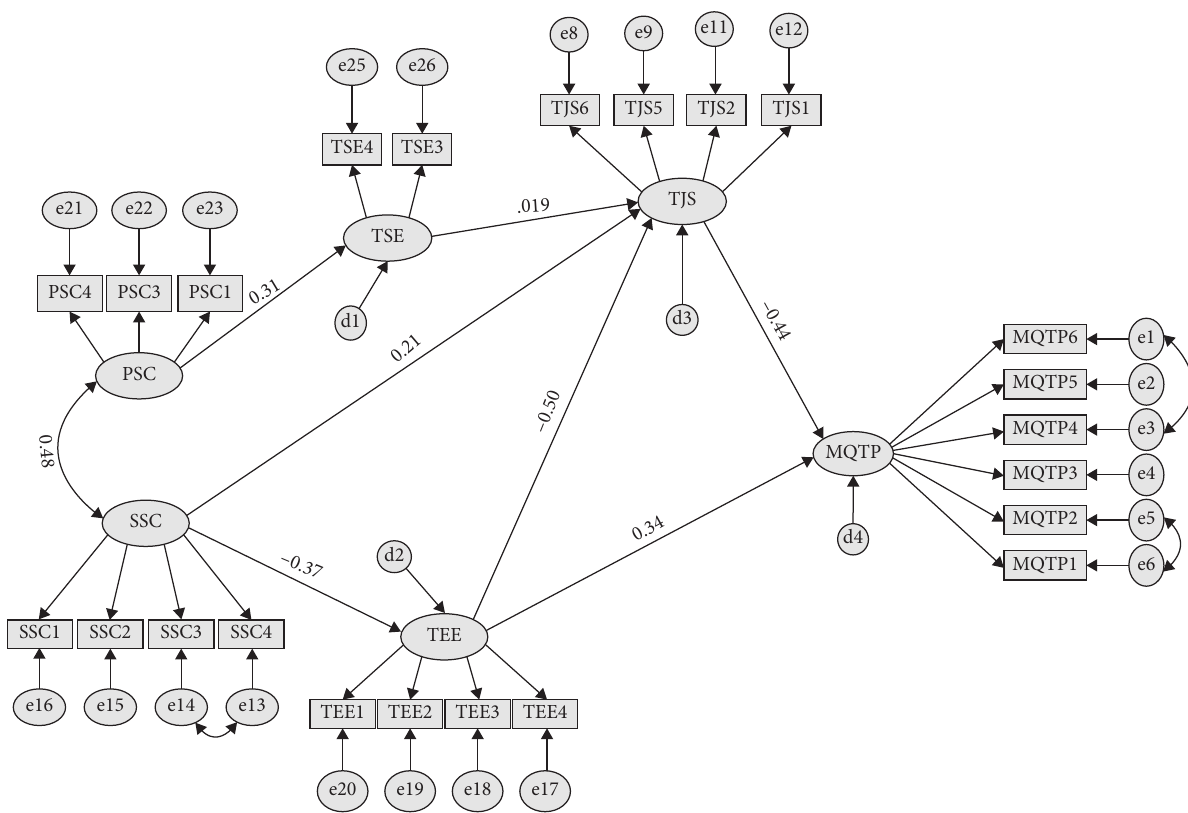
Figure 2: The final study. Table 7: Differences regarding teaching experience